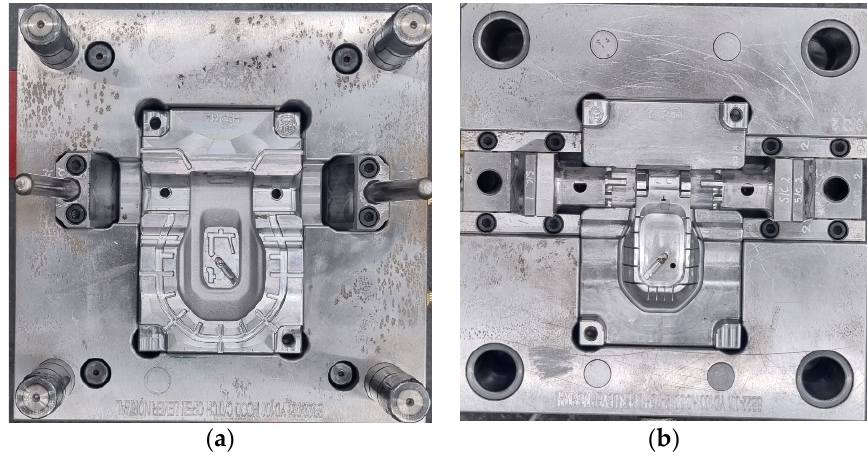
Figure 18. Mold of the open lever applying 0.5% shrinkage-rate constant. ( a ) Lower part. ( b ) Upper part.